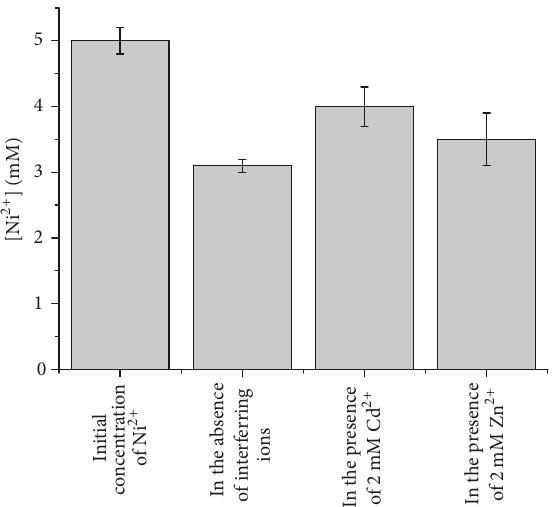
Figure 8: Effect of the presence of Cd 2+ and Zn 2+ on the ability of Mn12 to remove nickel ions from an ultrapure water solution containing 5 mM of Ni 2+ at pH 7. Each measurement was repeated on 3 different